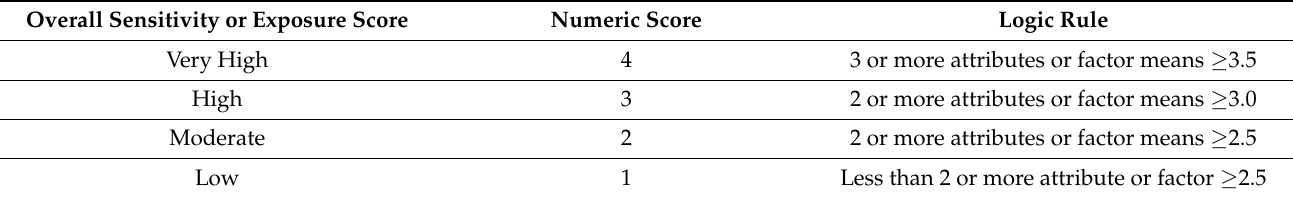
Table 5. Logic rule for calculating overall species’ climate exposure and biological sensitivity (from